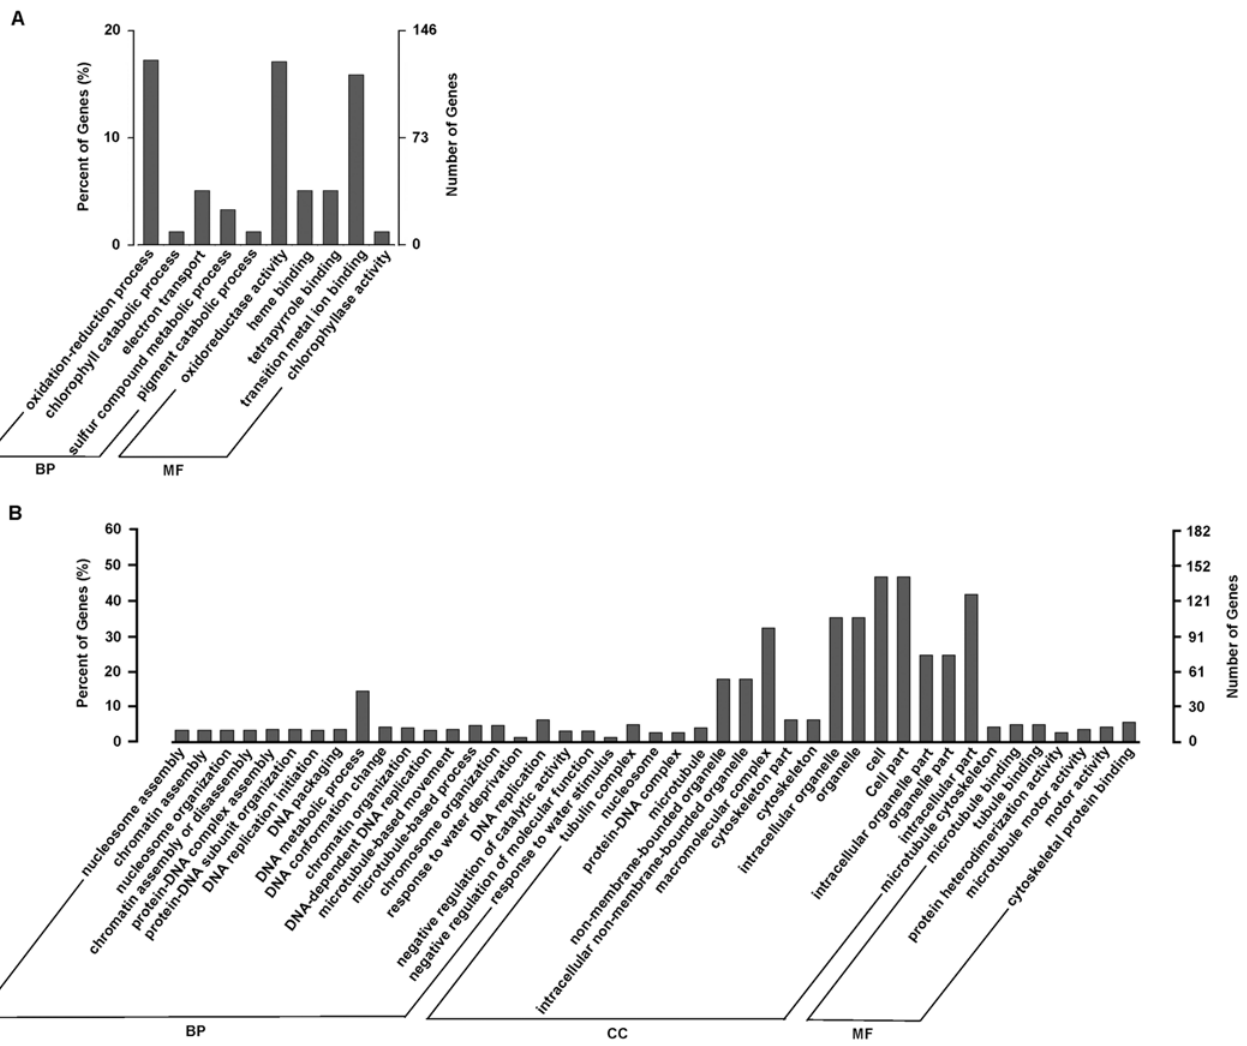
Fig 9. GO categories of biological process (BP), cellular component (CC) and molecular function (MF) for the early water-stress responding genes (P-6h vs . P-0h) in A . sparsifolia primary roots. (A) the early water-stress inducible genes; (B) the early water-stress repressed genes. The right y-axis shows the number of genes in a category, and the left y-axis indicates the percentage of a specific category of genes in that main